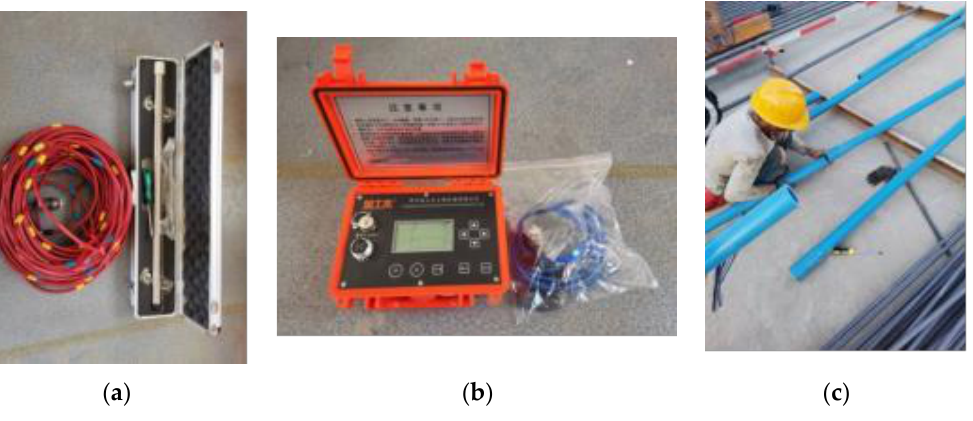
Figure 8. Instruments for radial displacement monitoring. ( a ) Movable vertical clinometer. ( b ) Readout instrument for clinometer. ( c ) Pipe for clinometer. Table 3. Monitoring frequency.